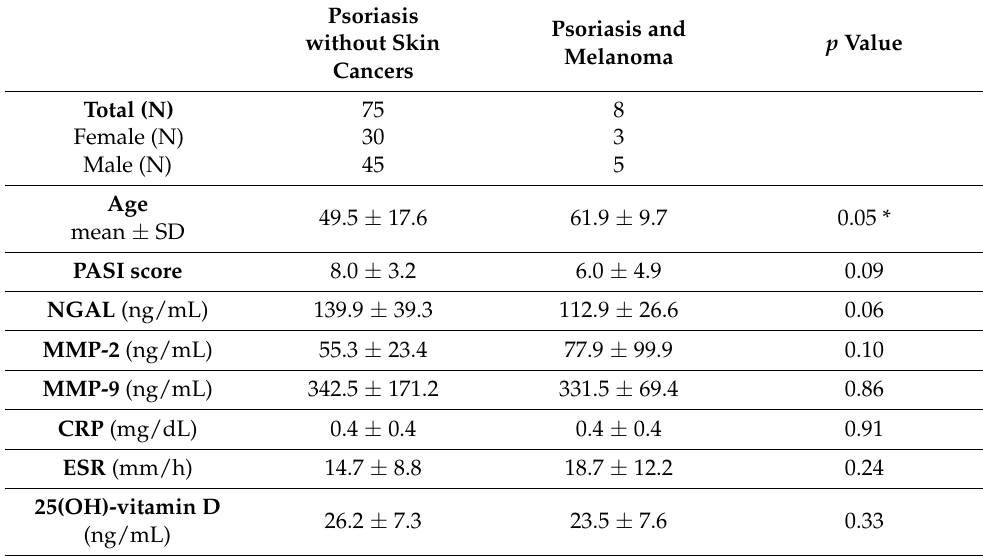
Psoriasis Psoriasis and without Skin Cancers